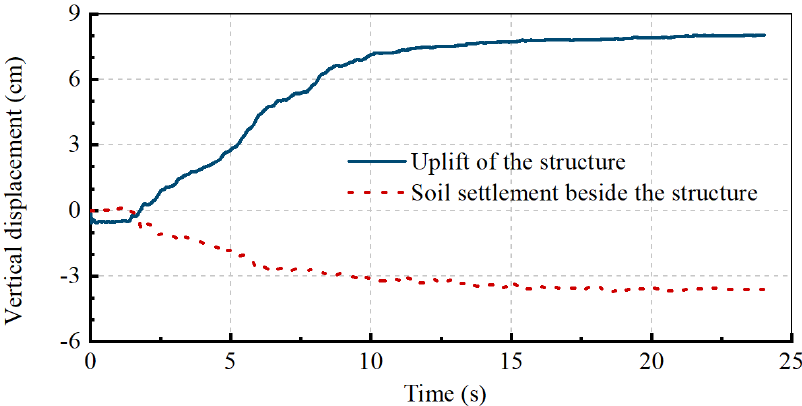
Figure 11. Time histories of vertical displacement of the midpoint of the top slab and the surrounding soil in the 2 m burial depth model.